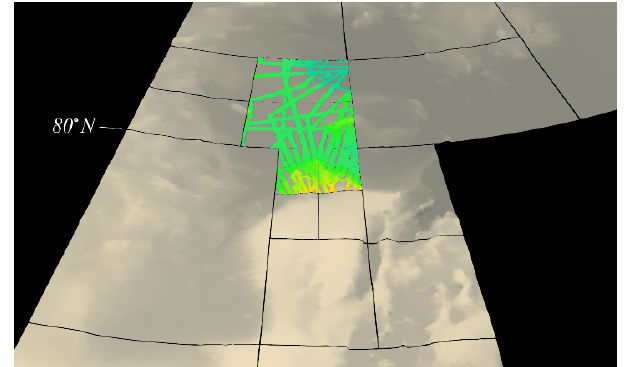
Figure 7. Data tiles north and south of 80 ◦ .